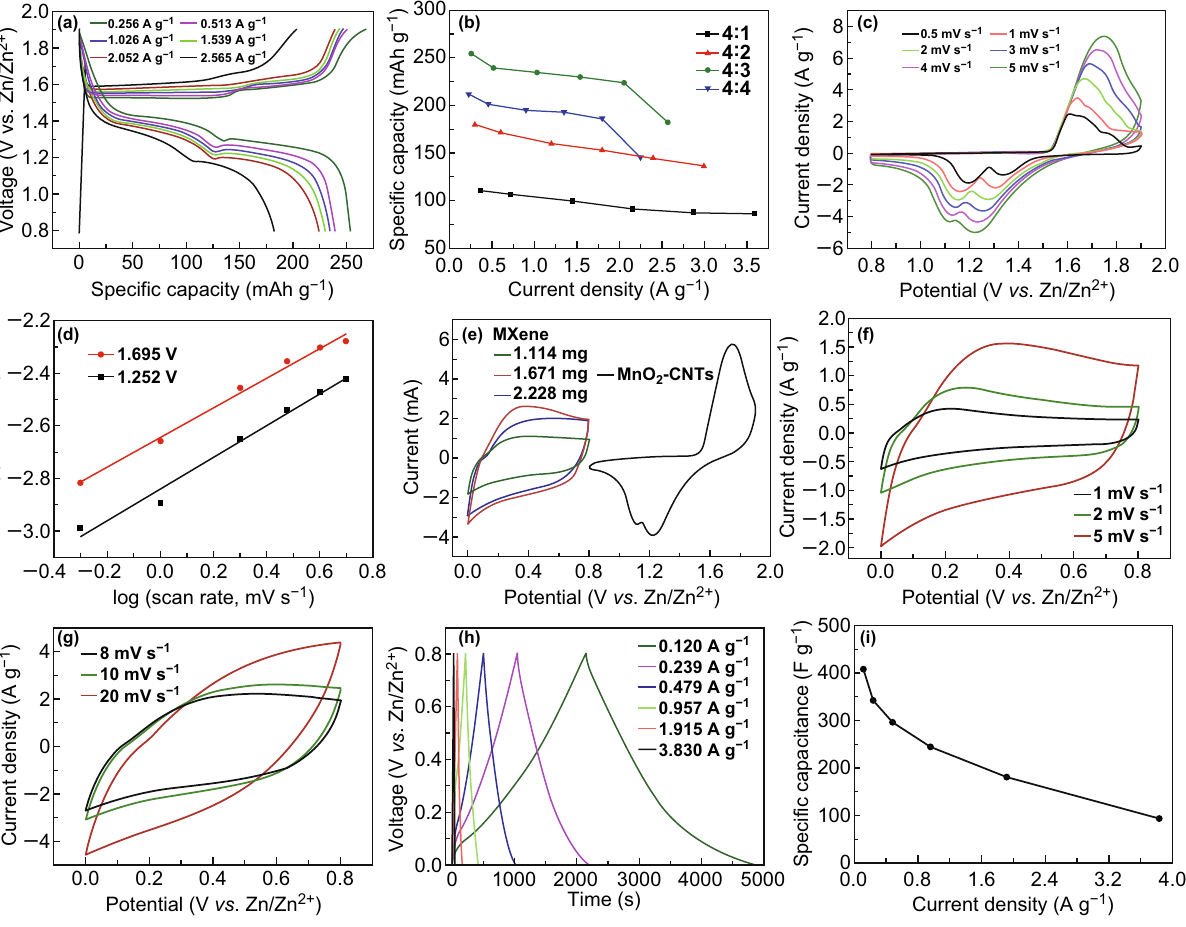
Fig. 3 Electrochemical performance of the MnO 2 –CNTs and MXene electrodes. a GCD curves with various current densities of the optimum MnO 2 –CNTs electrode. b Specific capacitance versus current density of the MnO 2 –CNTs electrodes with various CNTs to MnO 2 weight ratios. c CV curves with various scan rates of the optimum MnO 2 –CNTs electrode. d log ( i ) versus log ( v ) plots of the current response at the voltages of 1.695 V and 1.252 V. e CV curves of the MXene electrodes (various mass loadings) and MnO 2 –CNTs cathode at a scan rate of 5 mV s −1 . f , g CV curves with various scan rates, h GCD curves with various current densities, and i specific capacitance versus current density of the MXene